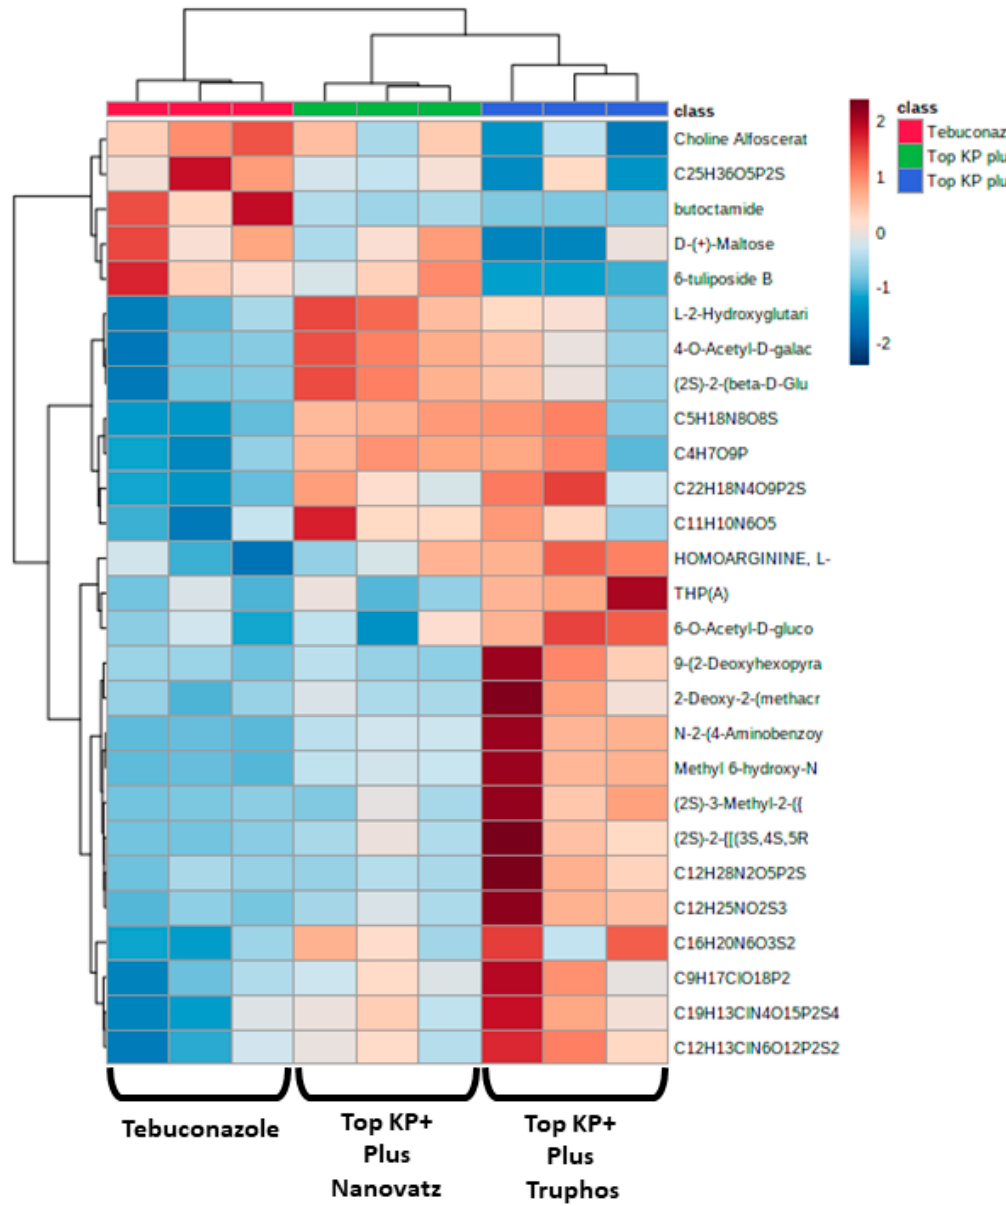
Figure 4. Heatmap and Hierarchical Cluster Analysis graph for all metabolites